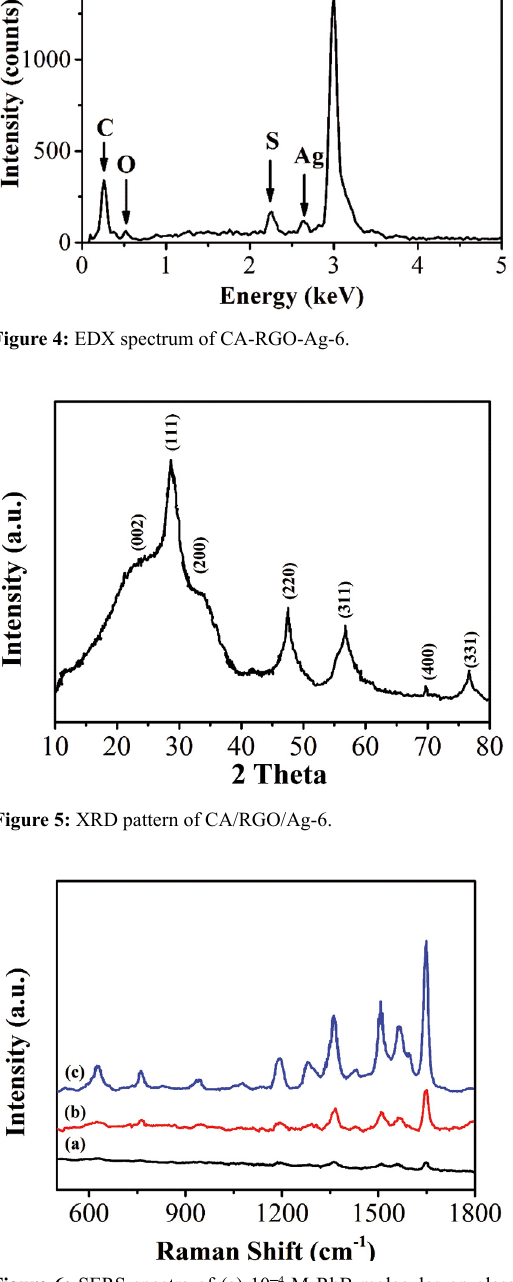
Figure 6: SERS spectra of (a) 10 ─4 M RhB molecules on glass reference surface, (b) 10 ─4 M RhB adsorbed on the RGO-Ag and (c) CA-RGO-Ag-3 substrates.